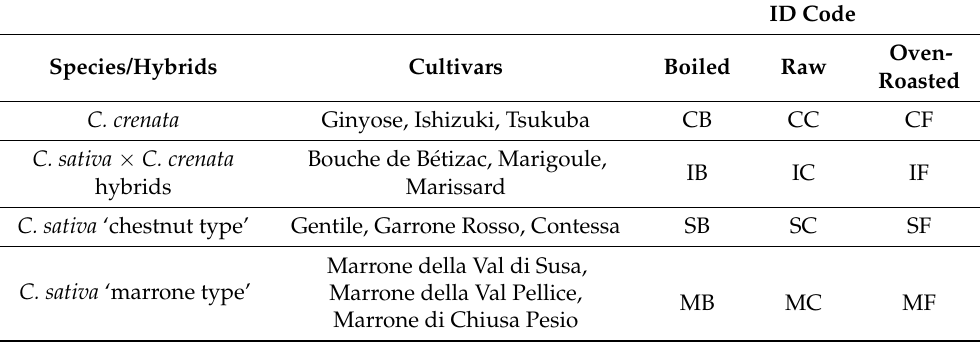
Table 1. ID codes of the considered chestnuts (boiled, raw, and oven-roasted). The table shows the cultivars for each selected chestnut